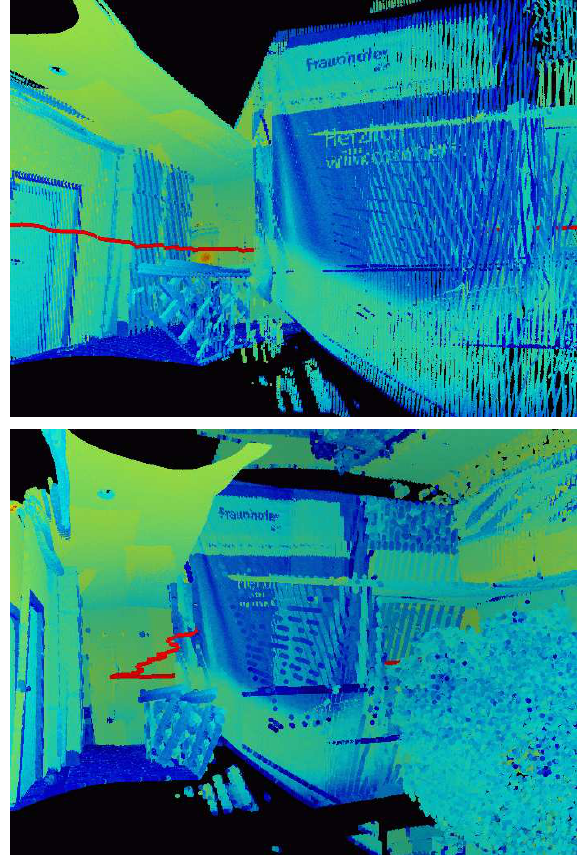
Figure 8. Overall view of the final result. The points have been colored using reflectances and the red line denotes the trajectory.